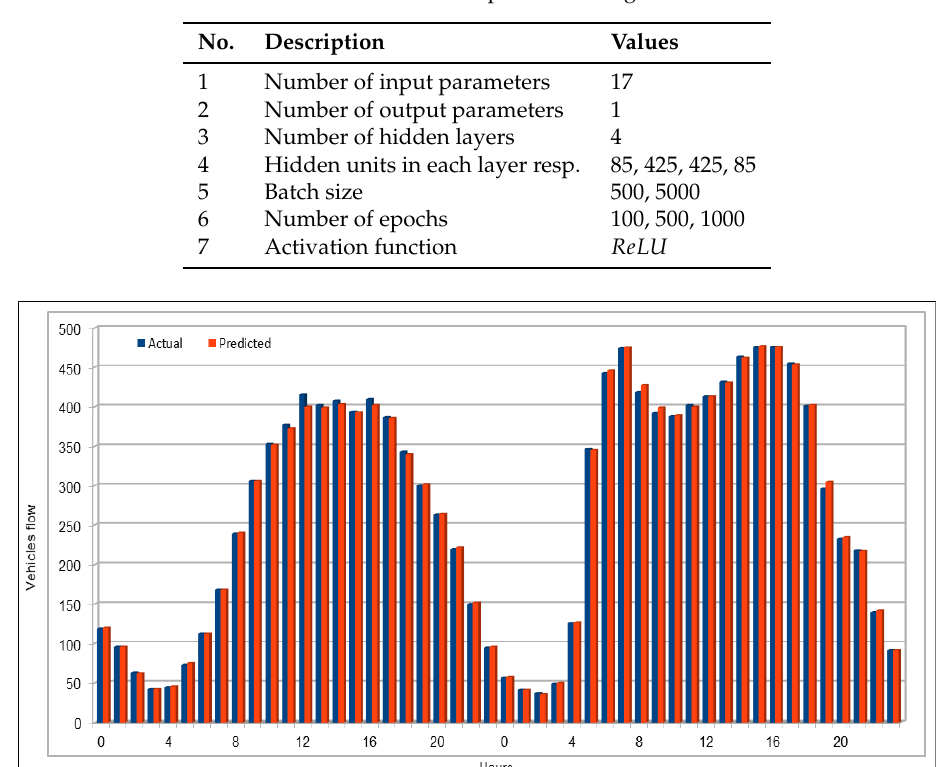
Table 3. Traffic flow: Deep model configuration.